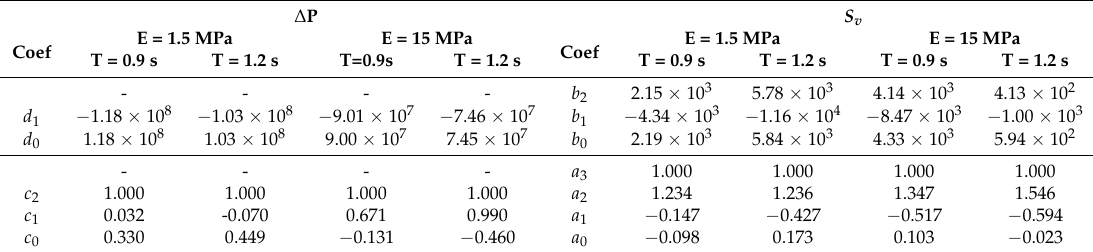
Table 4. Coefficients calculated for the validation process.